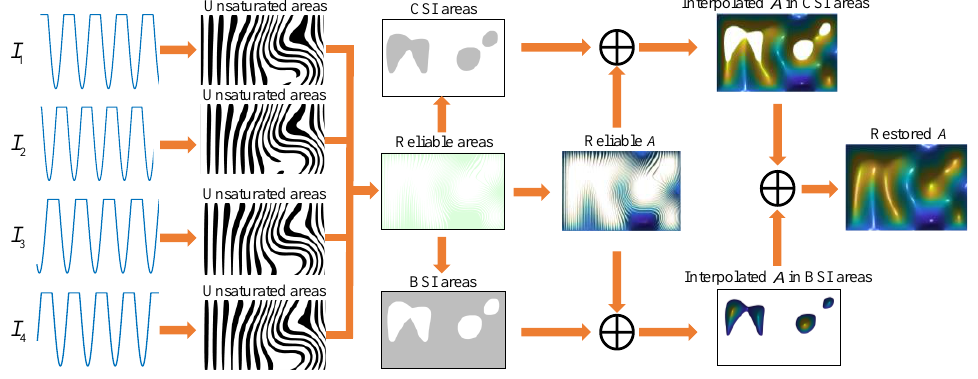
Figure 5. Flowchart of restoration of A .